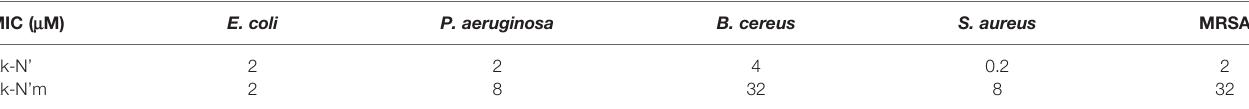
TABLE 3 | MIC values of Ak-N ’ and Ak-N ’